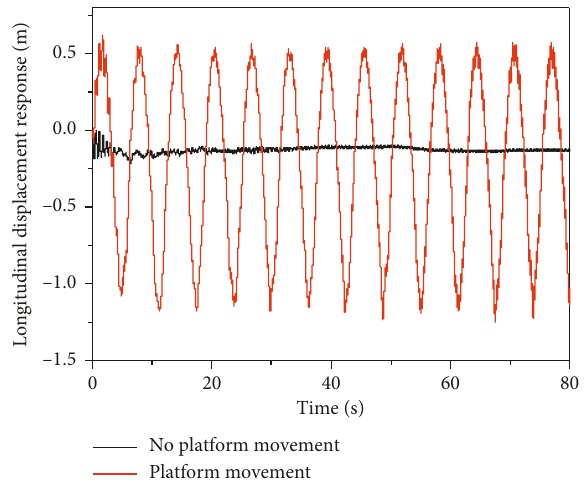
Figure 15: Effect of platform motion on longitudinal displacement.